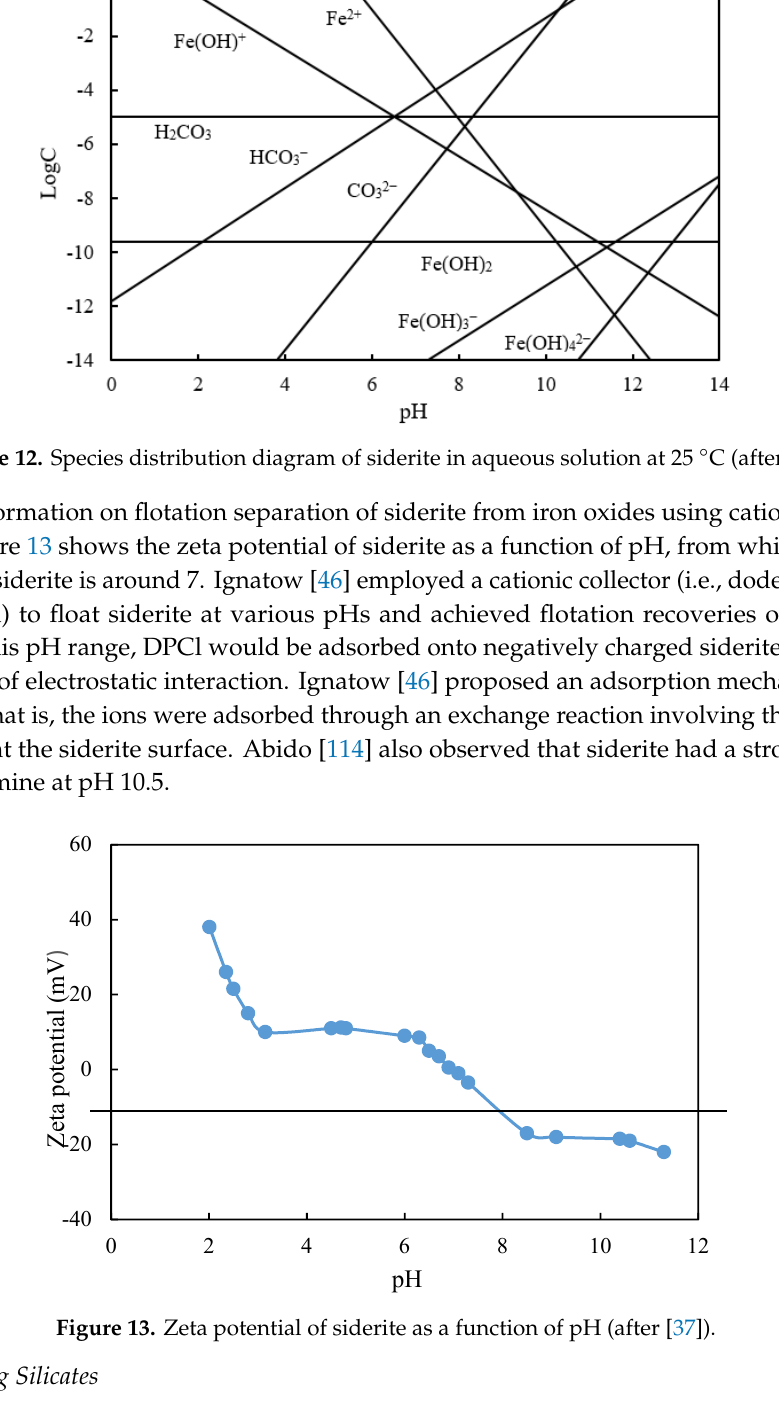
Figure 12. Species distribution diagram of siderite in aqueous solution at 25 °C (after [5]). It is possible to separately remove siderite and quartz from iron oxides using anionic collectors.